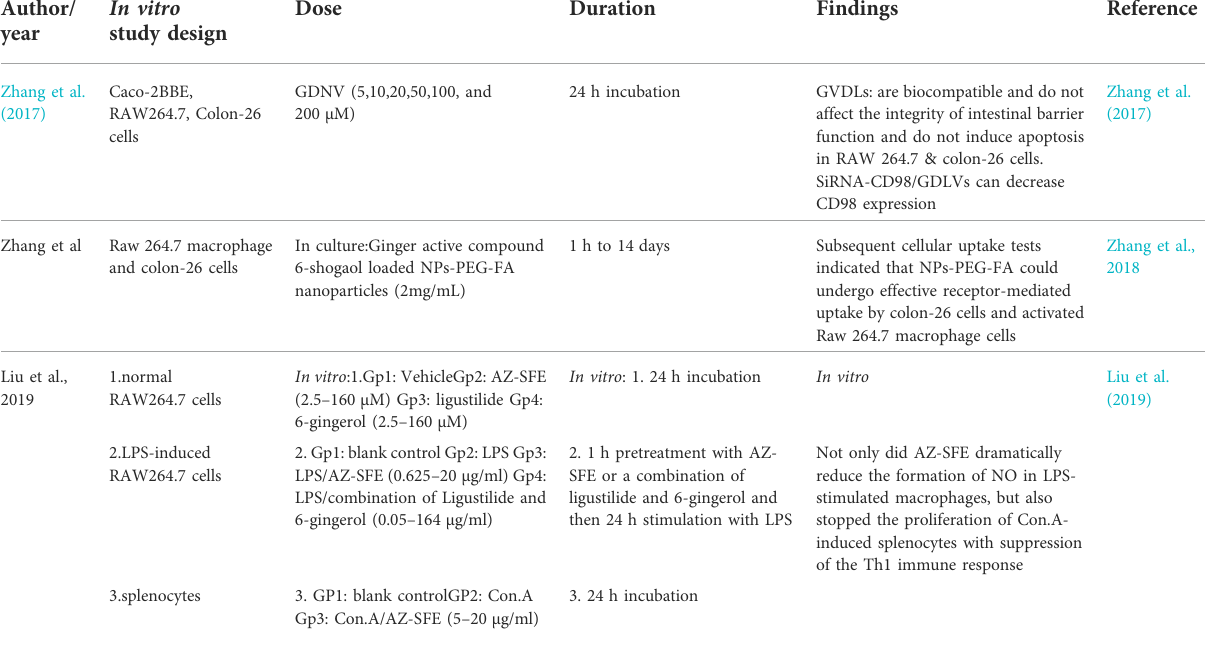
TABLE 2 The characteristics of the included in vitro studies on the effect of ginger on